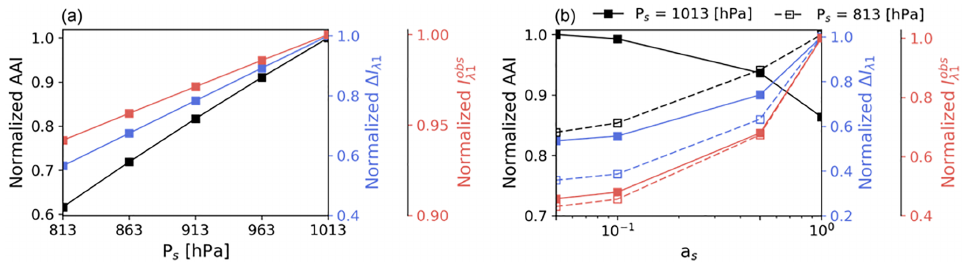
Figure 5. AAI sensitivity to surface parameters P s (a) and a s (b) . The solid line and dashed line in panel (b) indicate terrain height at sea